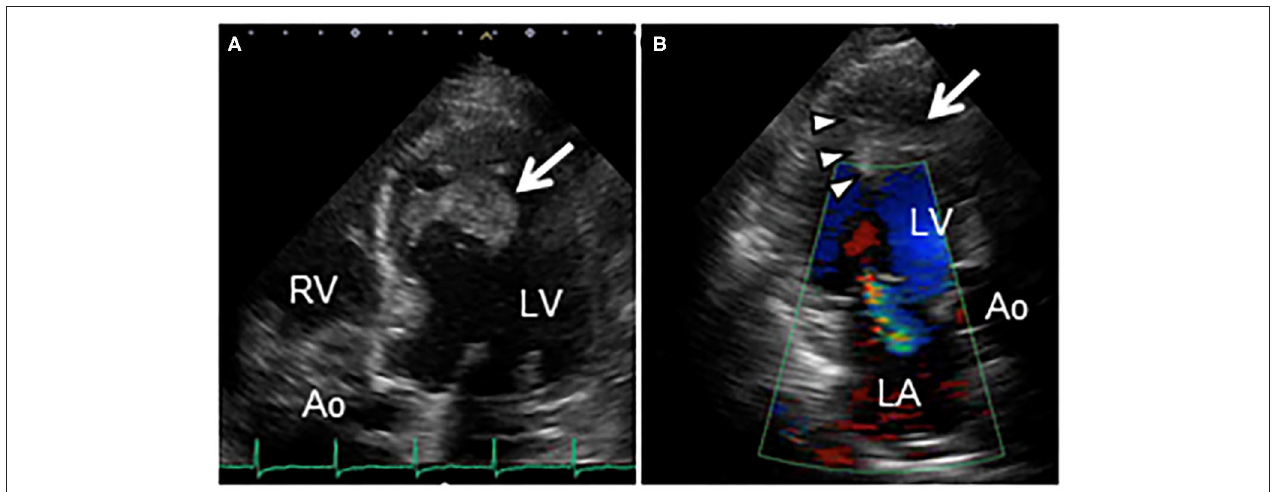
FIGURE 2 | (A) Transthoracic echocardiography in apical 5-chamber view reveals an echo-dense mass (30 × 39mm, arrow) attached to the mid-anteroseptal wall of the left ventricle, extending to the anterolateral papillary muscle. (B) Color Doppler echocardiography in apical 3-chamber view reveals a cardiac mass (arrow), and entrapment of the anterolateral papillary muscle (arrowheads), causing moderate mitral regurgitation. Ao, Aorta; LA, Left atrium; LV, Left ventricle; RV, Right ventricle.